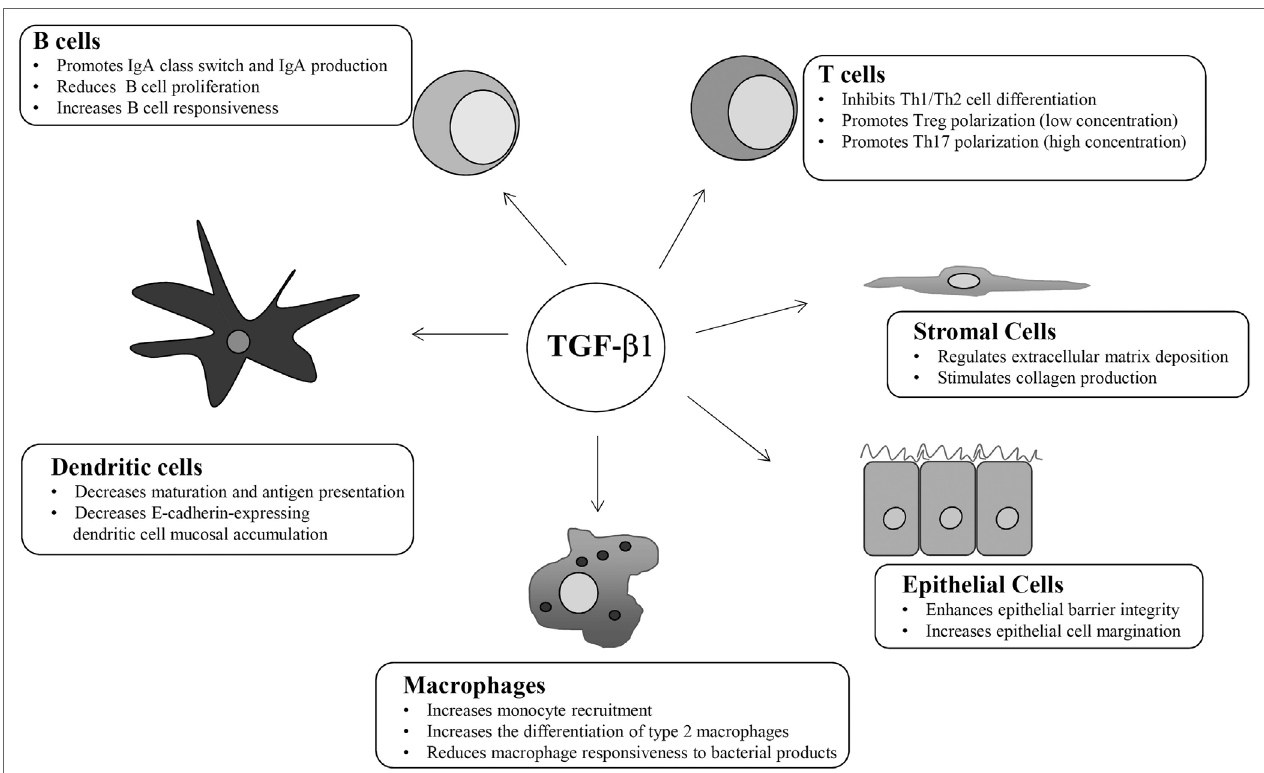
FiGURe 2 | Schematic view of the main cell targets and biological function of transforming growth factor (TGF)- β 1 in the